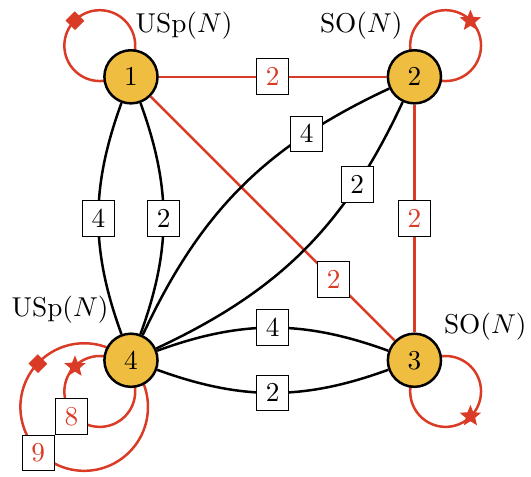
Figure 17 . Quiver diagram for the Spin(7) orientifold of phase S of Q 1 , 1 , 1 using the involution in eqs. (5.10), (5.11) and (5.12), together with our choice of γ